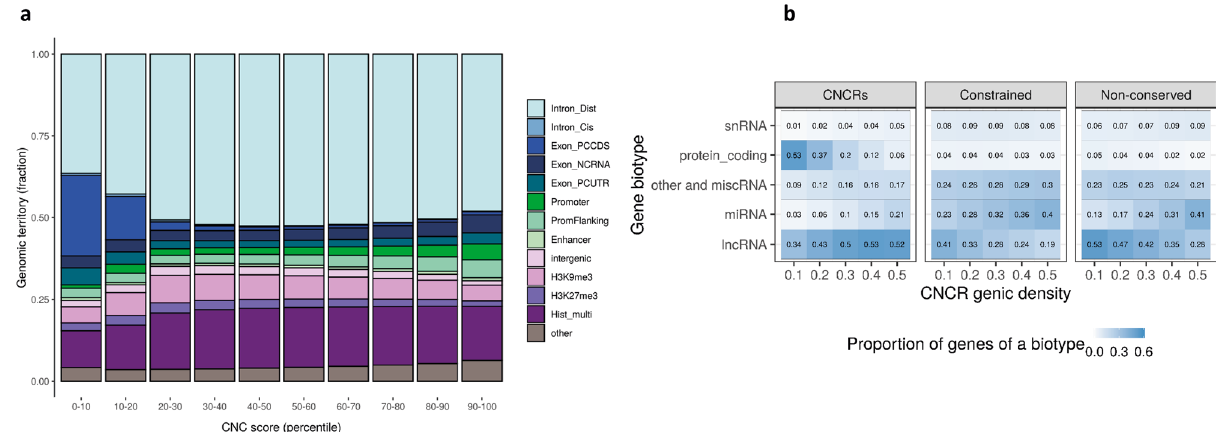
Fig. 2 Genomic territory and biotype proportions of constrained, non-conserved regions. Composition of the constrained genome, partitioned by constrained, non-conserved (CNC) scores ( a ) and proportion of biotypes of genes in our annotation (constrained, non-conserved regions: CNCRs) and in the comparator annotations (constrained regions and non-conserved regions) ( b ). The description for each genomic feature is shown in Supplementary Table 1. The barplot in a shows the genomic features for the 12.5% most constrained regions with CNC scores partitioned by decile, such that the highest decile (90 – 100) represents the most constrained and least conserved regions. Description of gene biotypes in b is taken from Ensembl 42 . The heatmap demonstrates the proportion of genes of a certain biotype within the three separate annotations within each genic CNCR density cut-off. CNCR density is de fi ned as the proportion of CNCRs within a gene taking into account the gene size. Protein coding is de fi ned by a gene that contains an open reading frame. The subclassi fi ed components of long non-coding RNA (lncRNA) found in the annotations are: Antisense — has transcripts that overlap the genomic span (i.e. exon or introns) of a protein-coding locus on the opposite strand; lincRNA (long interspersed ncRNA) — has transcripts that are long intergenic non-coding RNA locus with a length > 200 bp; non-coding RNA is further subclassi fi ed into miRNA (microRNA); siRNA (small interfering RNA); snRNA (small nuclear RNA) and miscellaneous RNA (includes snoRNA (small nucleolar RNA) and tRNA (transfer RNA)). Pseudogenes are similar to known proteins but contain a frameshift and/or stop codon(s) which disrupts the open reading frame. These can be classi fi ed into processed pseudogene — a pseudogene that lacks introns and is thought to arise from reverse transcription of mRNA followed by reinsertion of DNA into the genome and unprocessed pseudogene — a pseudogene that can contain introns since produced by gene